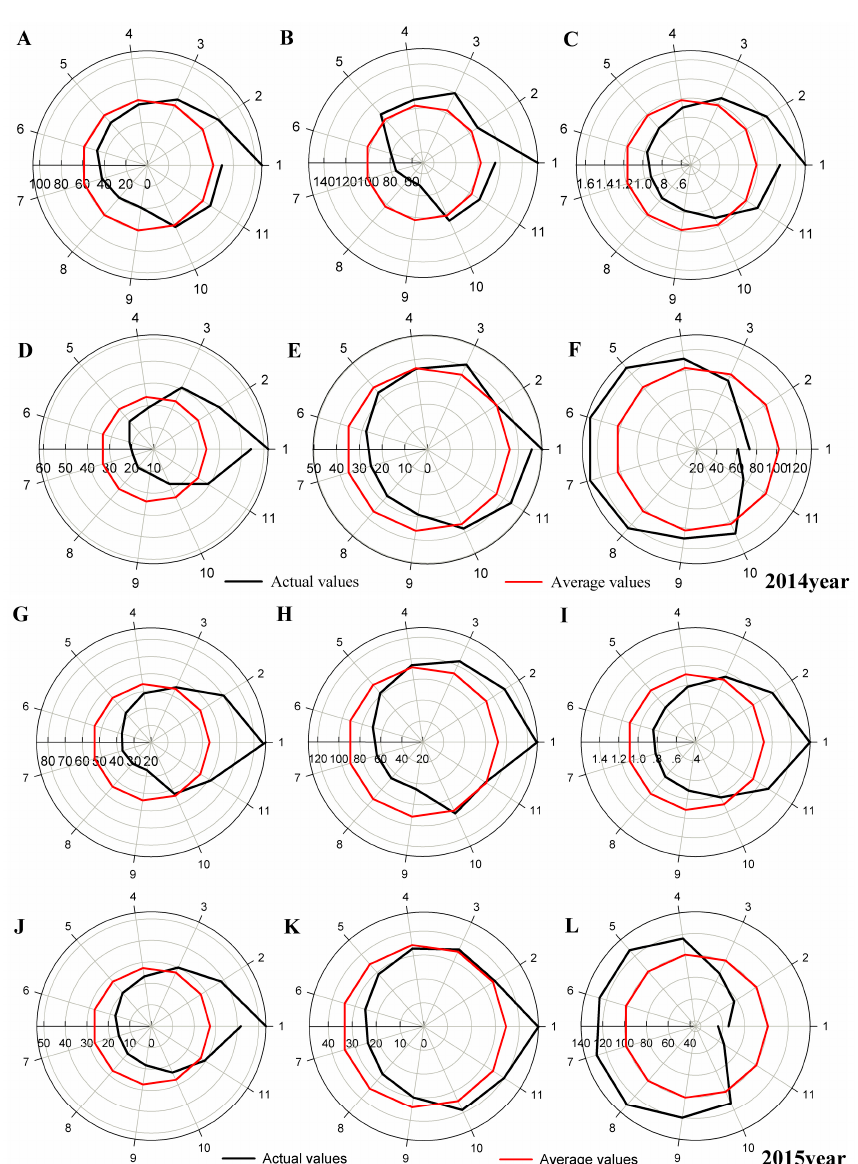
Figure 2. The monthly dynamics of the principal air pollutants over China (2014 and 2015). Graphs ( A – F ) represent the monthly concentration of PM 2.5 ( µ g/m − 3 ), PM 10 ( µ g/m − 3 ), CO (mg/m − 3 ), SO 2 ( µ g/m − 3 ), NO 2 ( µ g/m − 3 ), and O 3 ( µ g/m − 3 ) in 2014, respectively; Graphs ( G – L ) represent the monthly concentration of PM 2.5 ( µ g/m − 3 ), PM 10 ( µ g/m − 3 ), CO (mg/m − 3 ), SO 2 ( µ g/m − 3 ), NO 2 ( µ g/m − 3 ), and O 3 ( µ g/m − 3 ) in 2015,